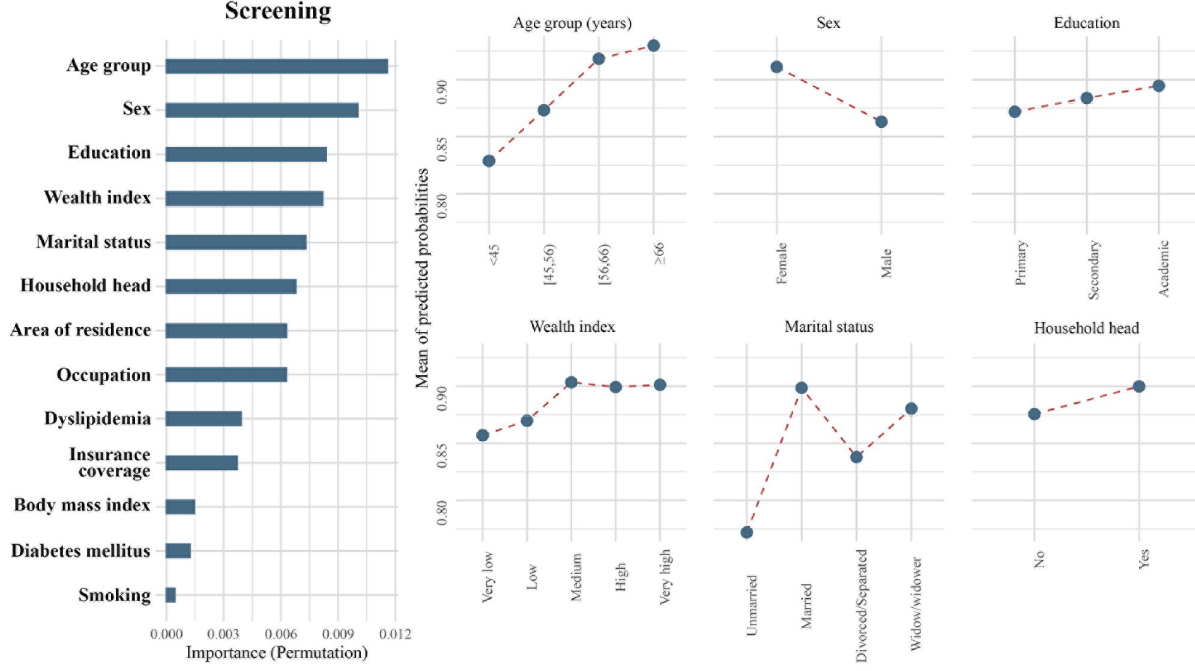
Fig 1. Importance of population characteristics and comparative probabilities of the top six important classifiers for